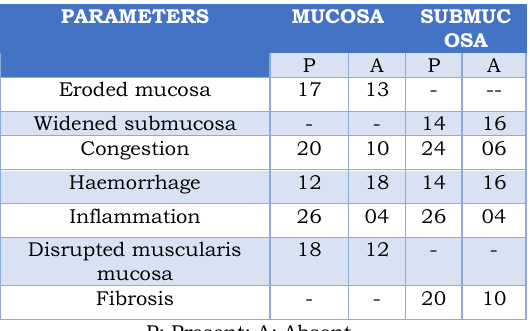
Table 1: Histological changes in mucosa and submucosa in cases of anorectal malformation PARAMETERS